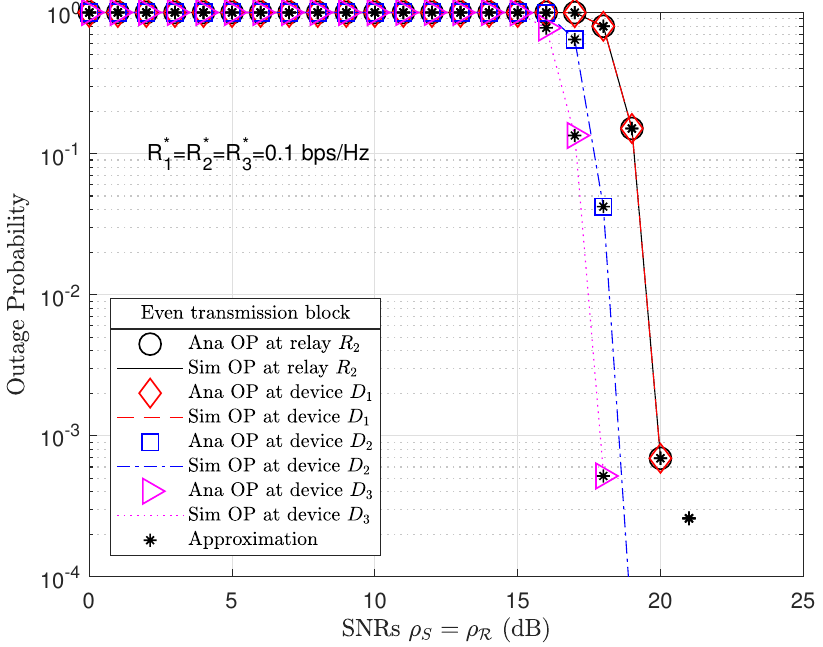
Figure 4. OP at relay R 2 and devices D n for n = { 1, . . . , N } in an even transmission block, where the number of antennas equipped at the BS, relay R 2 and devices D n are A 0 = 4, A 1 = 16, and A 2 = 2, respectively, and the PS factor λ =